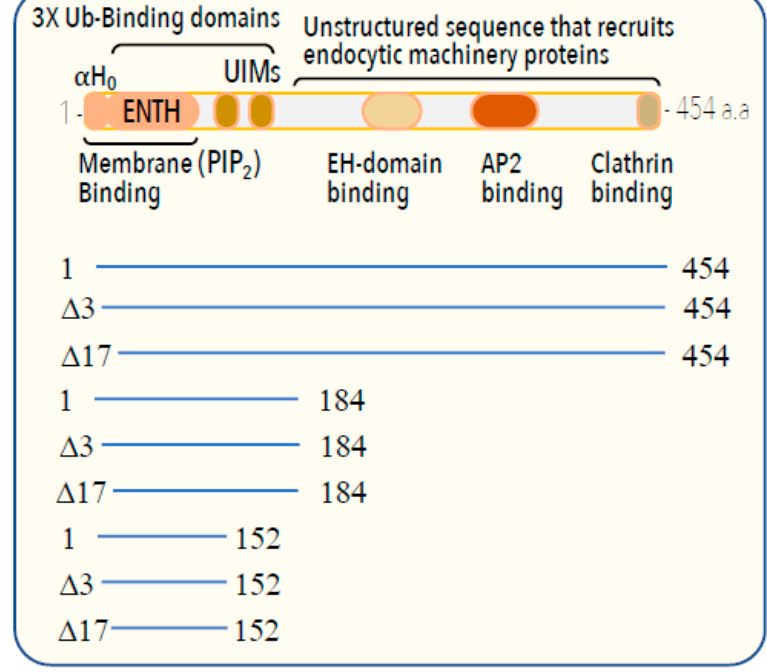
Figure 1. Domain architecture of epsin. The domains of yeast Ent1 and their main functions and partners are shown. Below, the main constructs examined in this study are shown.